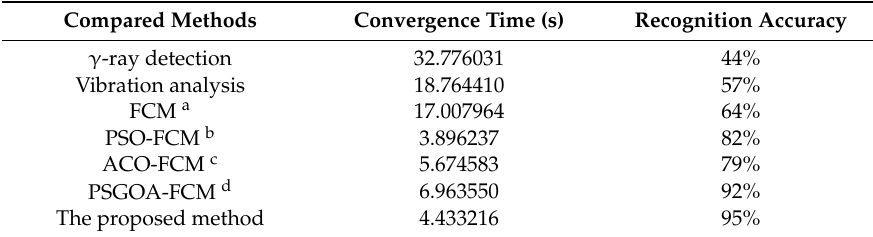
Table 4. Comparison of some related